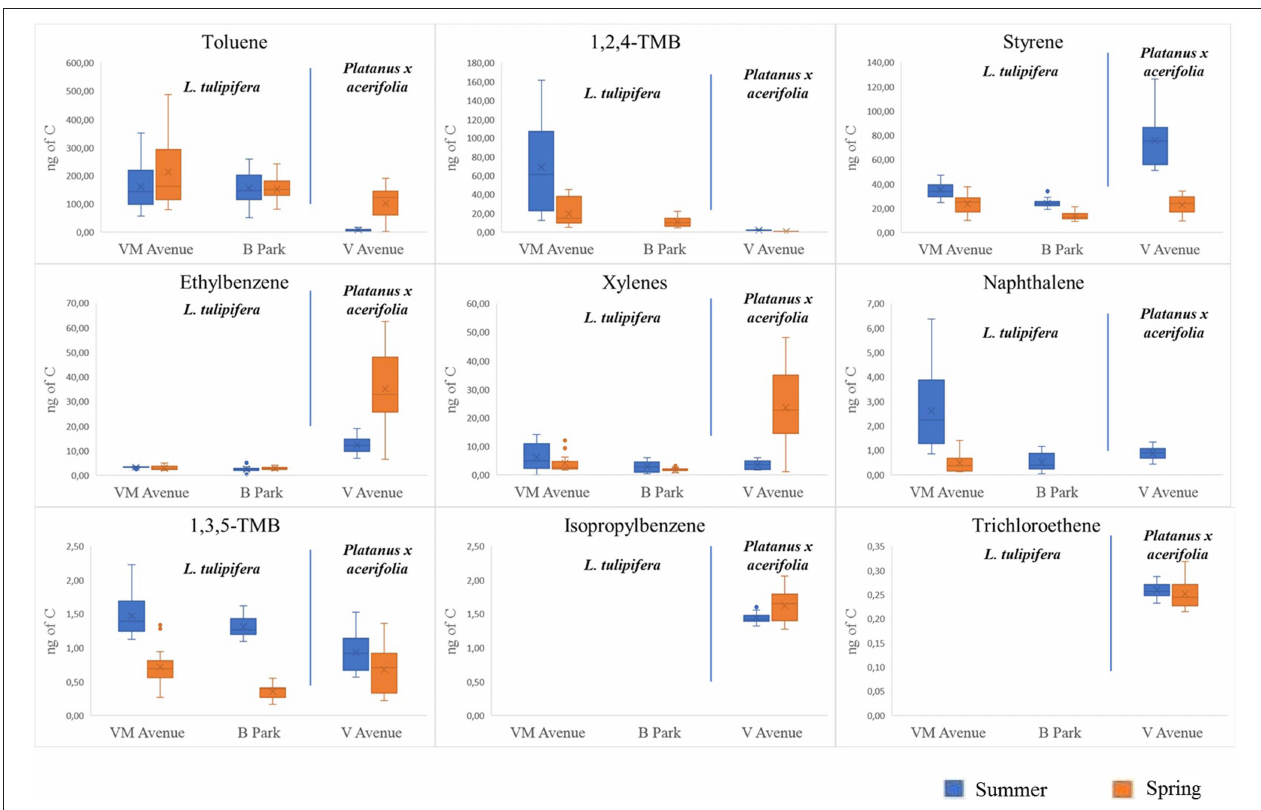
FIGURE 3 | Concentrations of individual AVOCs leaf content by the leaves of L. tulipifera and Platanus x acerifolia at the sampling sites VM Avenue, B Park, and V Avenue in both summer and spring. Concentrations are expressed as ng of C. In the boxes: X = arithmetic mean; horizontal line =